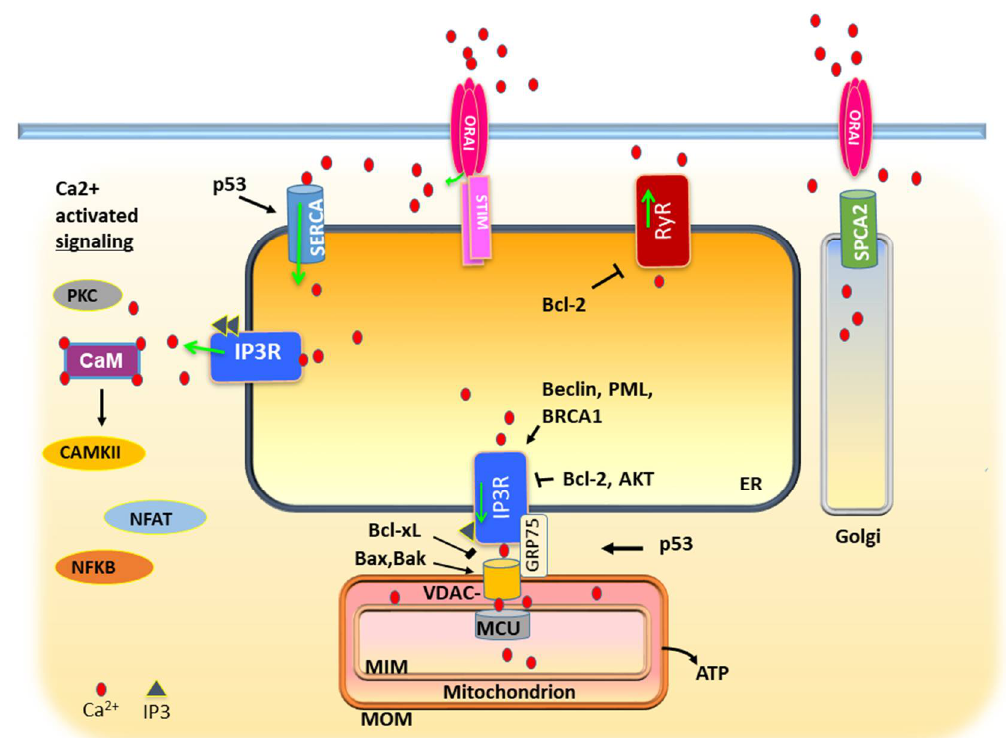
Figure 1. Storage, utilization, and renewal of intracellular calcium: a simplified view of core Ca 2+ signaling machinery. Cytosolic Ca 2+ is continuously sequestered into the ER by SERCA pumps. IP3 signals from certain cell-surface receptors (not shown) opens IP3R channels that direct Ca 2+ to the cytosol or mitochondrion. Ca 2+ -binding proteins in the cytosol then stimulate a host of cell type-dependent signaling pathways. In some cell types, the IP3R may co-exist and functionally overlap with another channel, the ryanodine receptor, RyR. Ca 2+ transfer to mitochondrion is mediated by IP3R coupled to the mitochondrial channel VDAC by the adapter molecule GRP75. MCU then admits Ca 2+ to the inner matrix, where it drives metabolism and ATP production. Calcium overload causes apoptosis by disrupting membrane potential and releasing cytochrome C; thus, Ca 2+ transfer to mitochondria is tightly modulated, either positively or negatively, by regulators of proliferation, autophagy, and death such as the Bcl-2 family, Beclin, AKT, PML, p53, and BRCA1. Depletion of ER Ca 2+ causes the Ca 2+ sensor STIM1 to engage the plasma membrane Ca 2+ channel Orai1, causing an influx of extracellular Ca 2+ to the cytosol. SERCA pumps may associate with this complex, allowing more direct replenishment of ER Ca 2+ . The Golgi Ca 2+ pump SPCA2 can also bind and activate Orai1 to drive epithelial differentiation. See text for details. ER, endoplasmic reticulum; MOM, mitochondrial outer membrane; MIM, mitochondrial inner membrane; MCU, mitochondrial calcium uniporter; VDAC, voltage-dependent anion channel. Black arrows indicate positive regulation and T-bar indicates negative regulation. Green arrows denote direction of flow.